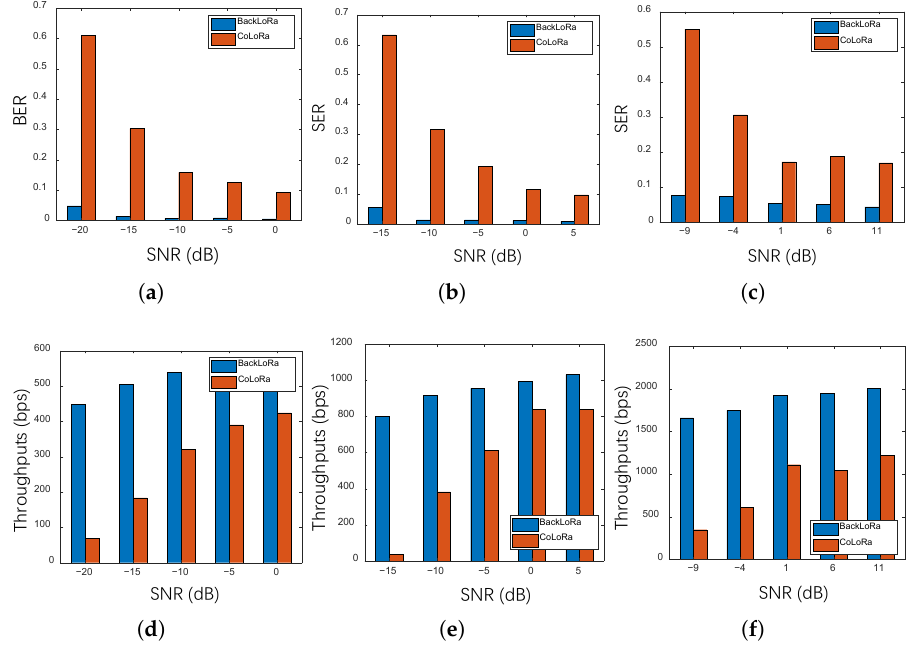
Figure 11. The SER and throughput in different SNRs with changing SF. ( a ) SER performance with different SNRs (SF = 12). ( b ) SER performance with different SNRs (SF = 10). ( c ) SER performance with different SNRs (SF = 8). ( d ) Throughput with different SNRs (SF = 12). ( e ) Throughput with different SNRs (SF = 10). ( f ) Throughput with different SNRs (SF =